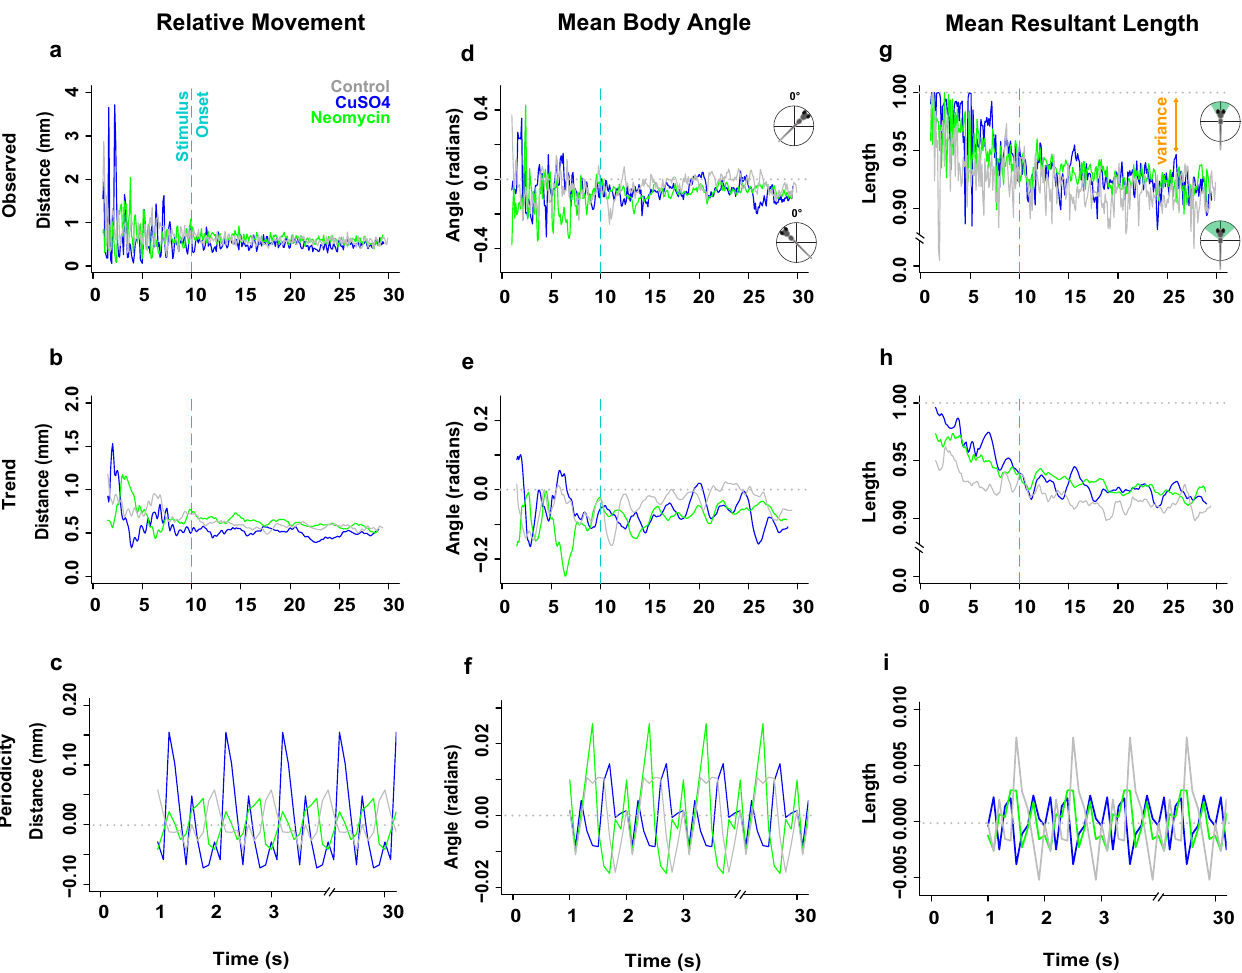
Fig. 7 The overall trends and periodic fl uctuations in the linear (relative distance moved) and angular (mean body angle, mean length of the resultant vector) motion parameters of rheotaxis behavior differ among treatment groups. (Note: the relative velocity and acceleration periodicity data mimicked the patterns observed in relative movement; see Supplementary Fig. 4). Gray = control ( n = 248 fi sh), blue = CuSO 4 ( n = 204 fi sh), green = neomycin ( n = 222 fi sh). Spectral decomposition of the observed data ( a , d , g ) removed the noise (Supplementary Fig. 3g, j, k) to reveal the overall underlying trends ( b , e , h ) and the periodicity, or recurring fl uctuations ( c , f , i ) that occurred during any given 1 s of the experiment. The periodicity waveform peaks ( c , f , i ) indicate the average amount (amplitude), number, direction (positive = increasing; negative = decreasing), and order of occurrence for these cyclic fl uctuations as a function of unit time (1 s). The overall trends were that CuSO fi sh had the least relative movement ( b ), while the control fi sh more 4 treated rapidly oriented to 0° ( e ) and swam with more angular variance (h; 1 – mean length of the resultant vector) compared to lesioned fi sh. The periodic fl uctuation in relative distance moved ( c ) was greatest in CuSO fi sh compared to control or neomycin treated fi sh. However, the fl uctuation in 4 treated mean body angle ( f ) was greatest in neomycin treated fi sh compared to control and CuSO 4 fi sh, while the fl uctuation in mean length of the resultant vector (i.e the angular variance; i ) was greatest in control fi sh compared to lesioned fi